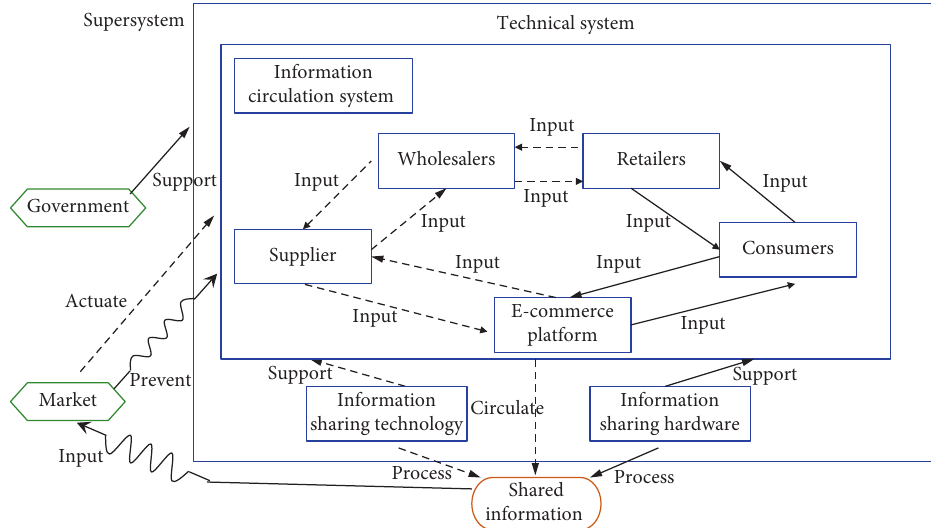
Figure 2: Functional model of information sharing system for dual-channel agricultural product supply